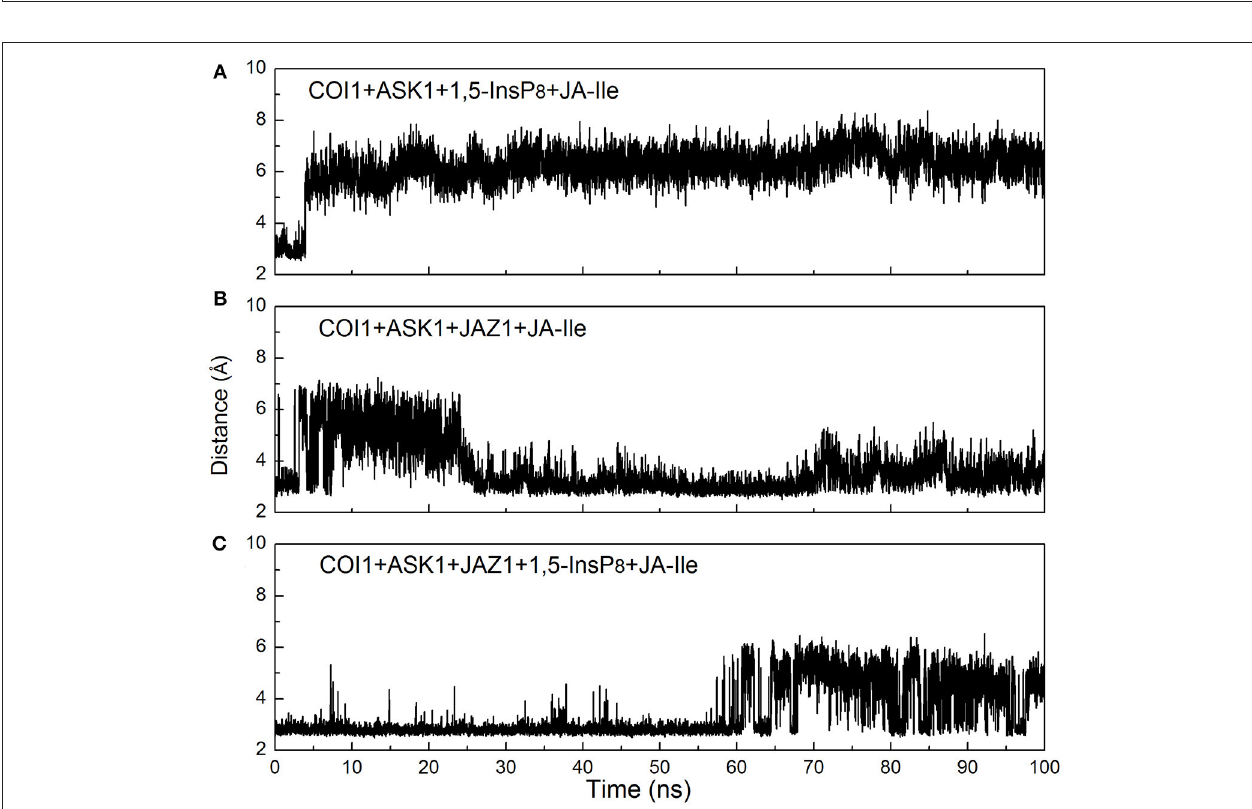
Based on the calculated binding free energy, the binding kcal/mol in system COI1 + ASK1 + 1,5-InsP 8 + JA-Ile, between COI1 and JA-Ile or JAZ1 is stronger in system COI1 + ASK1 + JAZ1 + JA-Ile, and COI1 + ASK1 + JAZ1 + 1,5- with 1,5-InsP 8 than those systems without 1,5-InsP 8 . The InsP 8 + JA-Ile, respectively. The predicted binding free statistical analysis affirmed that the differences are significant ( P < 0.05). The results indicate that the binding of InsP 8 4.94 kcal/mol in system with COI1 promotes the binding between COI1 and JA-Ile or